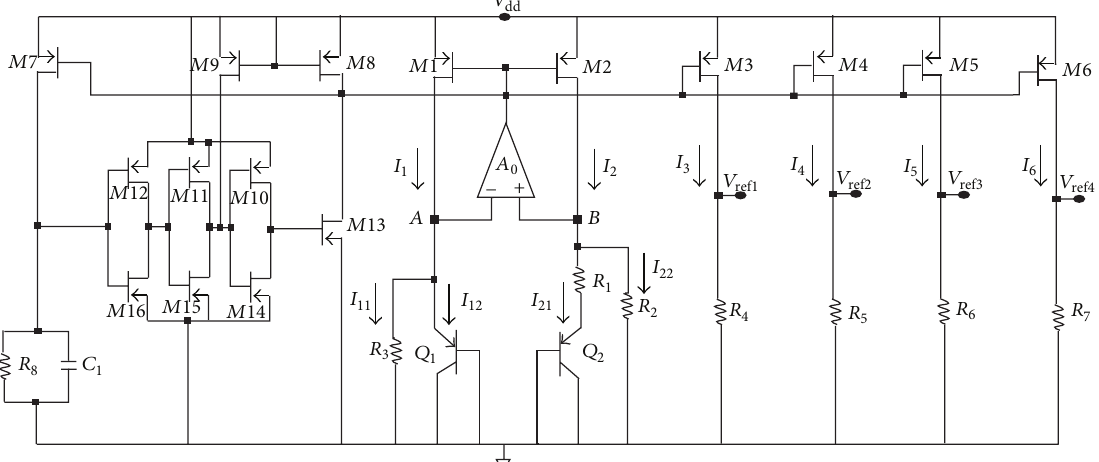
Figure 6: Bandgap reference